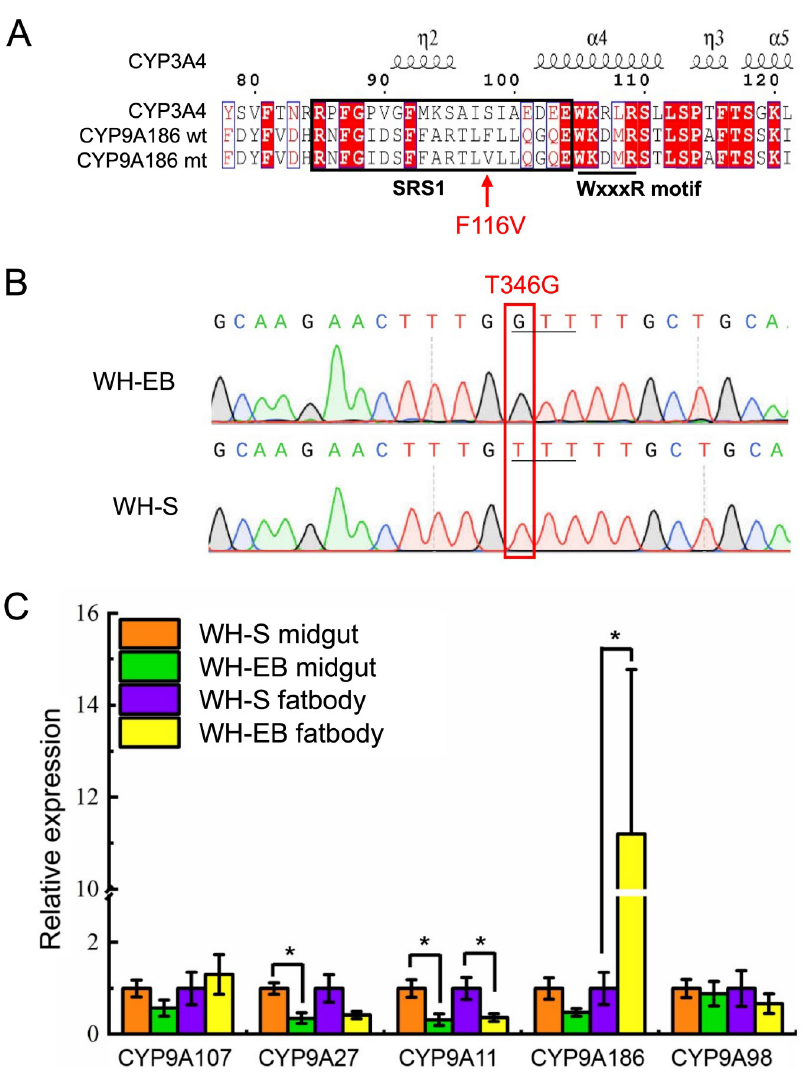
Fig 4. Identification of the CYP9A186 T346G mutation resulting in the F116V substitution and quantitative real- time PCR transcriptional analysis of CYP9A186 . ( A ) Alignment of the deduced CYP9A186 amino acid sequences from WH-EB and WH-S with a translated human cytochrome P450 (e.g., CYP3A4). The F116V substitution is shown with a red arrow. The predicted locations of alpha helical secondary structures are marked based on the template of the CYP3A4 protein structure (1TQN) using ESPript 3.0. ( B ) Representative chromatograms from direct sequencing of CYP9A186 PCR products from WH-EB and WH-S showing the T346G mutation. ( C ) qRT-PCR analysis of CYP9A107 , CYP9A27 , CYP9A11 , CYP9A186 and CYP9A98 in midgut and fat body from WH-S and WH-EB. Data shown represent means ± SE derived from four biological replicates. Asterisks indicate significant differences between the strains (Student’s t -test, p <